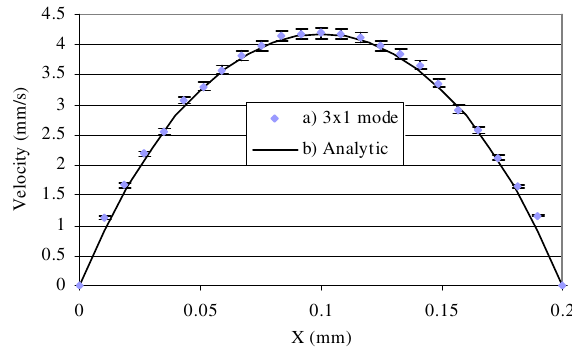
Fig. 4. (Color online) Velocity profiles (a) normal mode, (b) 2 × 1 vertical binning mode; (c) 3 × 1 vertical binning mode; (d) Solid curve depicts the analytically calculated velocity profile.